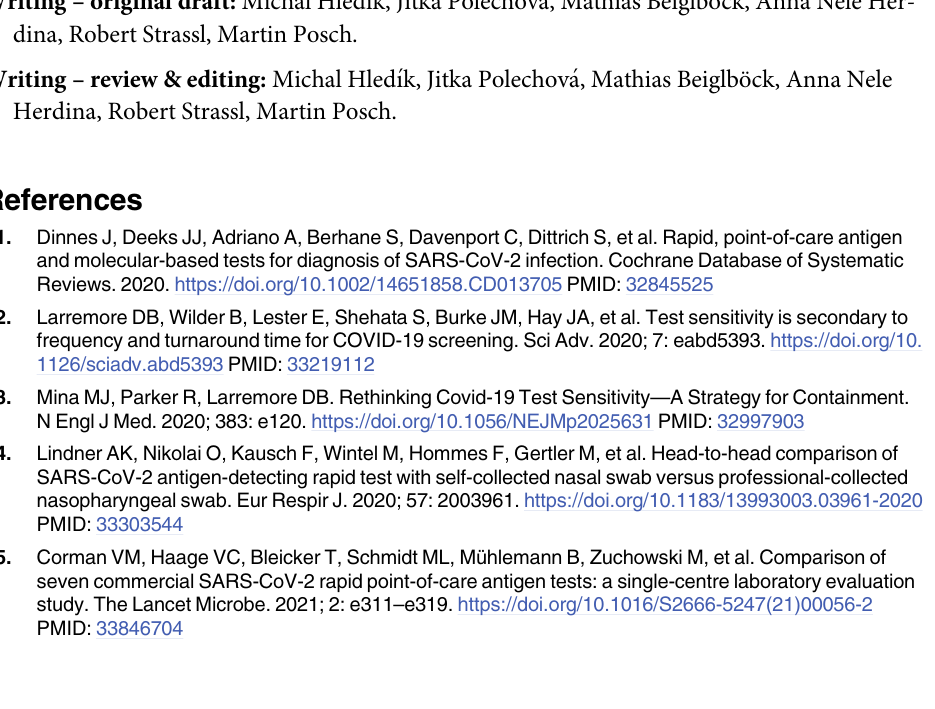
S1 Table. County, number of tests, number of positive tests, positivity rates, simultaneous Bonferroni adjusted 95% confidence intervals, and standard errors of the positivity rates in the 79 counties. Counties are ordered from low to high incidence by the upper confidence bound. Data source